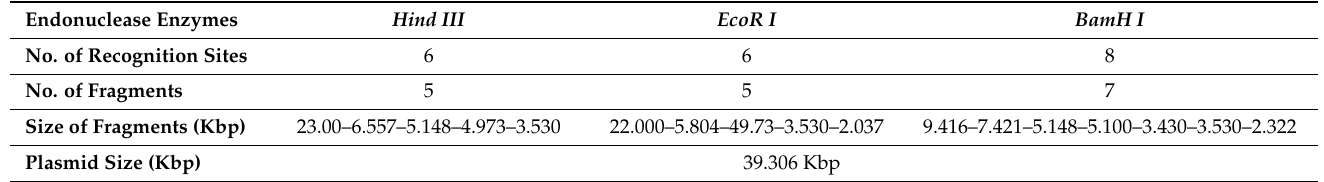
Table 1. The restriction configurations of plasmids isolated from vancomycin-resistant S. aureus